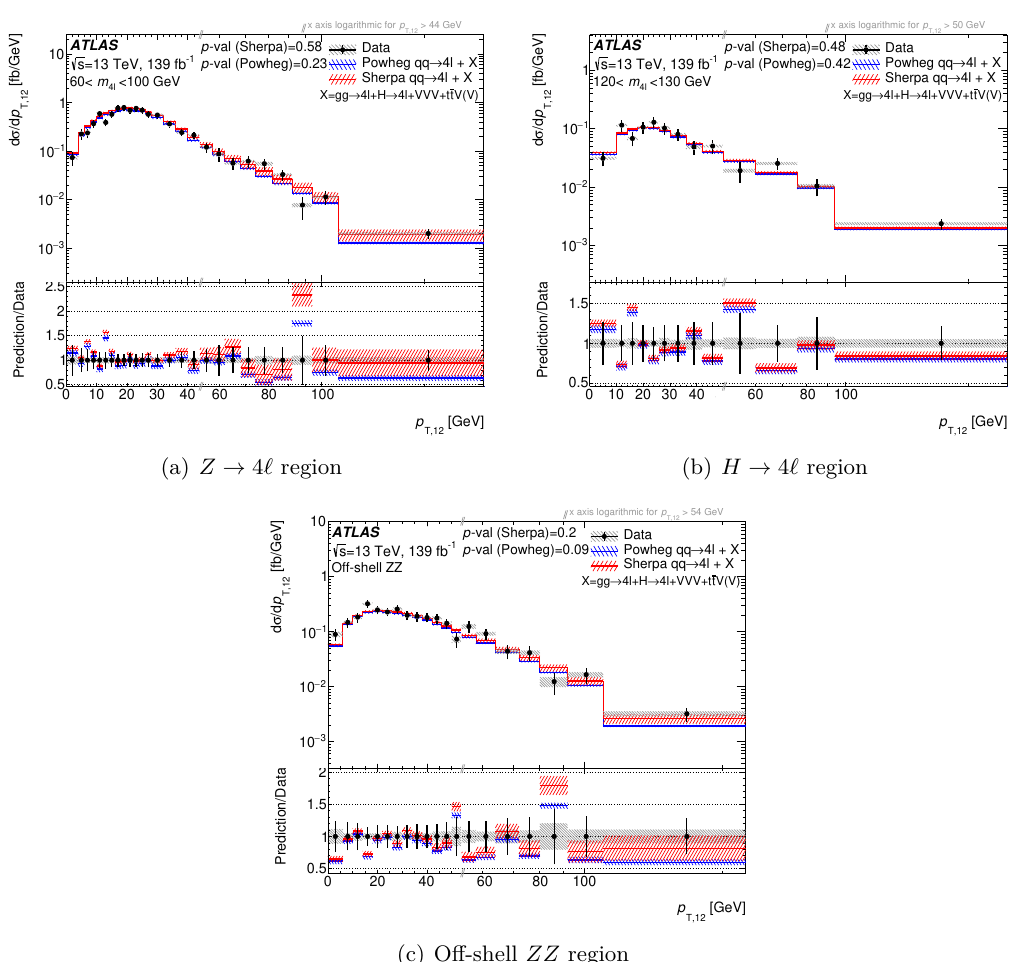
Figure 17 . Differential cross-section as a function of p T , 12 in m 4 ‘ regions. The measured data (black points) are compared with the SM prediction using either Sherpa (red, with red hashed band for the uncertainty) or Powheg + Pythia8 (blue, with blue hashed band for the uncertainty) to model the q ¯ q → 4 ‘ contribution. The error bars on the data points give the total uncertainty and the grey hashed band gives the systematic uncertainty. The p -value is the probability for the χ 2 , with the number of degrees of freedom equal to the number of bins in the distribution, to have at least the observed value, given the SM prediction. The lower panel shows the ratio of the SM predictions to the data. In (a) the x -axis is on a linear scale until p = 44 GeV, where it switches T , 12 to a logarithmic scale; in (b) it switches at p = 50 GeV, and in (c) at p = 54 T , 12 T , 12